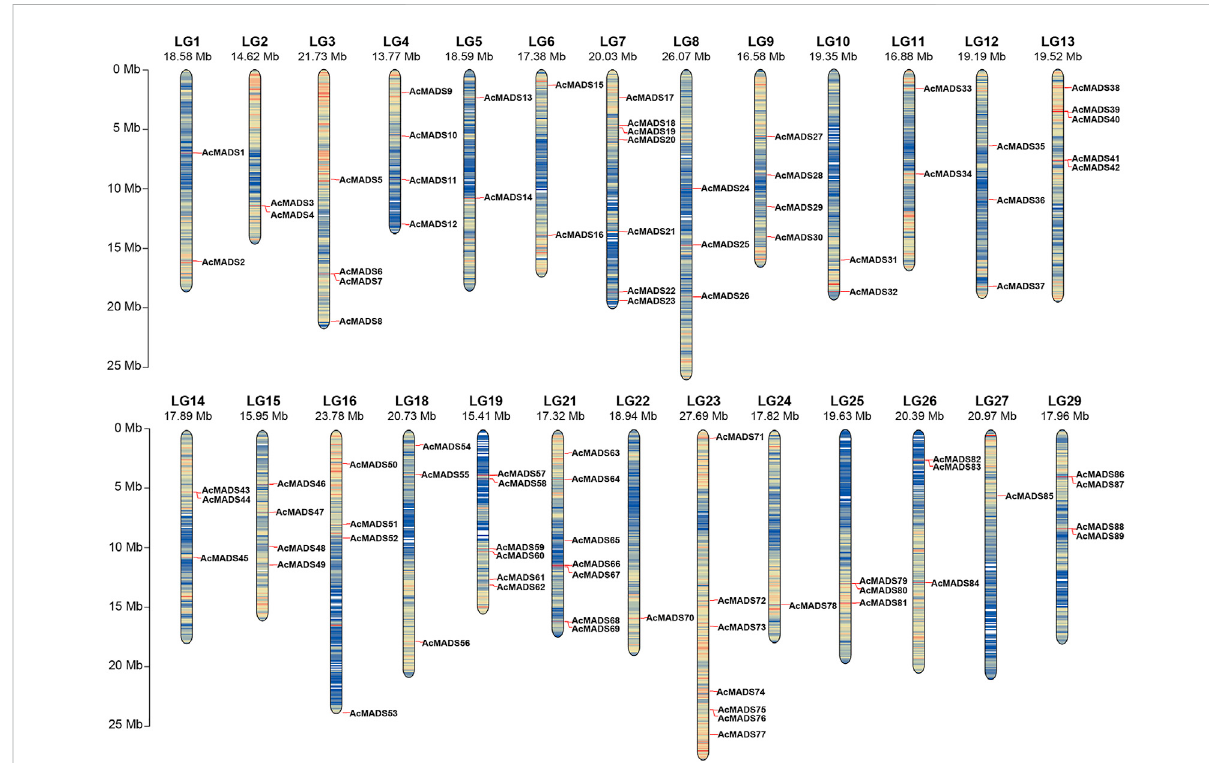
FIGURE 1 Chromosomal distribution of the A. chinensis MADS-box genes. LG17, LG20, and LG28 have no AcMADS-box gene distribution. The chromosome numberismarkeredatthetop,andthecolorsfrombluetoredoneverychromosomeindicate genedensity.Thechromosomelength scale is located on the